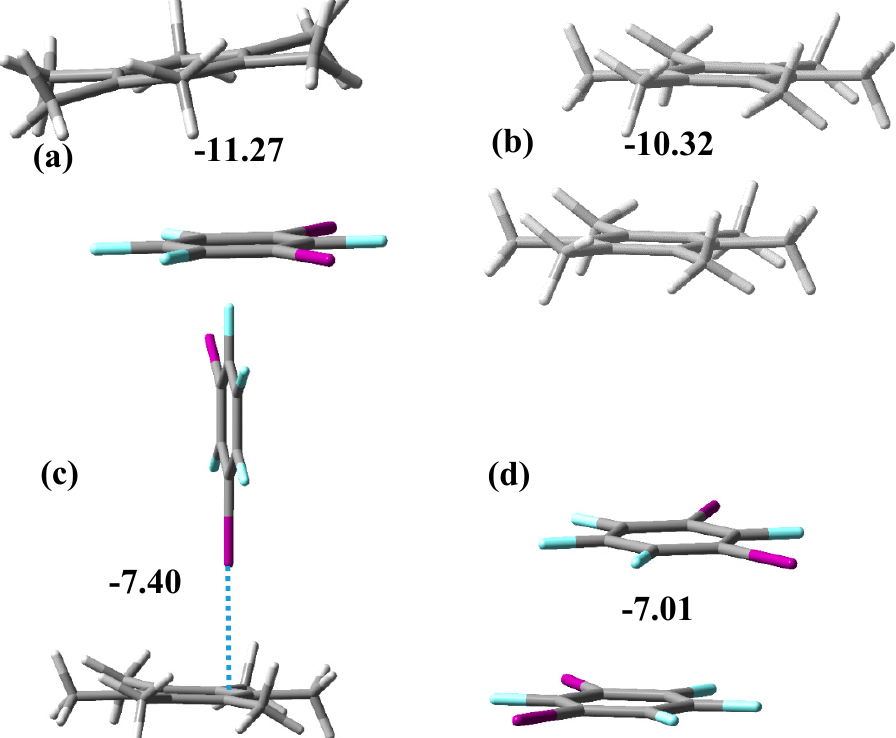
Figure 2. The interaction energies (black numbers, in kcal / mol) for the stacked complex between HMB and 1,3-DITFB ( a ), a stacked HMB dimer ( b ), a halogen-bonded complex between HMB and 1,3-DITFB ( c ), and a stacked 1,3-DITFB dimer ( d ).